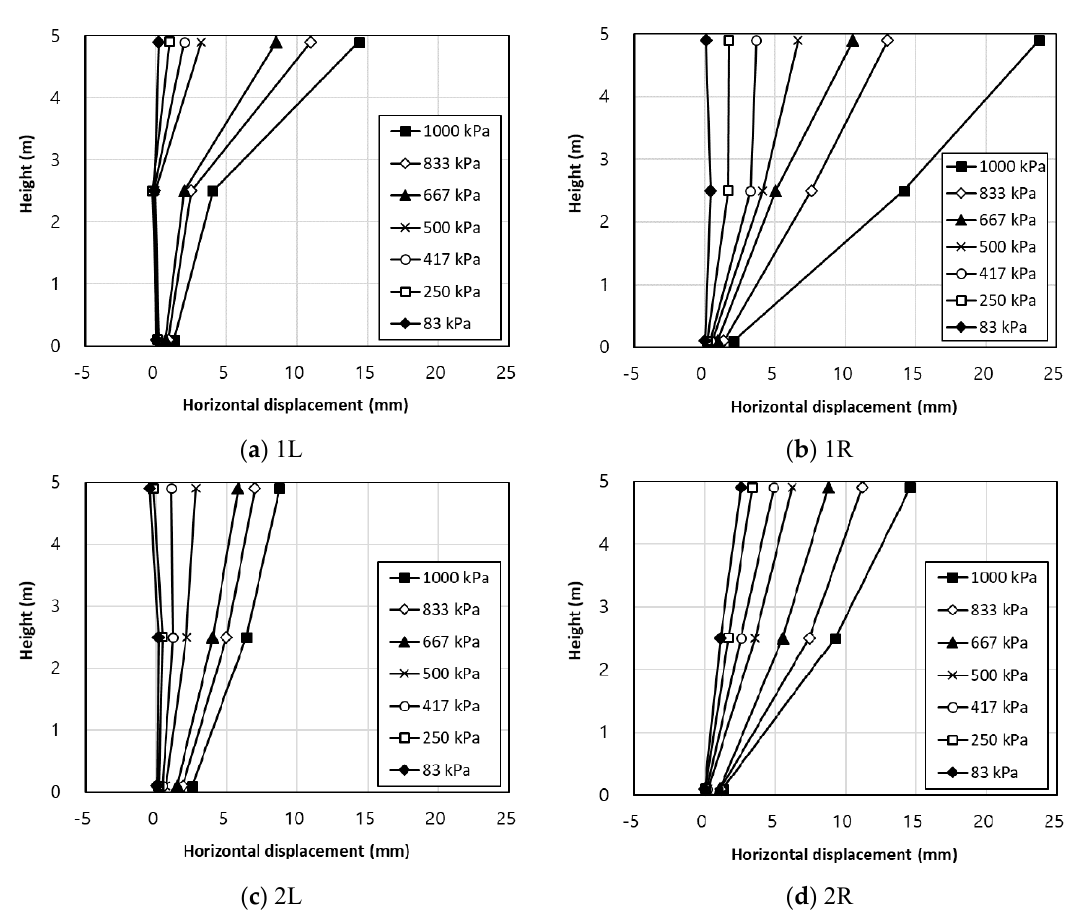
Figure 15. Horizontal displacement of wall with respect to height.